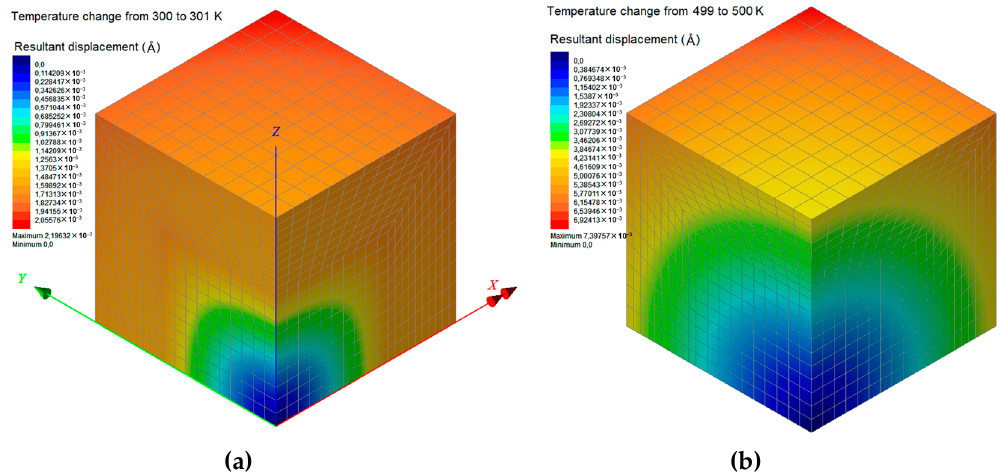
Figure 18. Contours of the resultant displacement of the nanocomposite RVE with a mass fraction w C240 = 0.05, for a temperature change ( a ) from 300 to 301 K and ( b ) from 499 to 500 K.